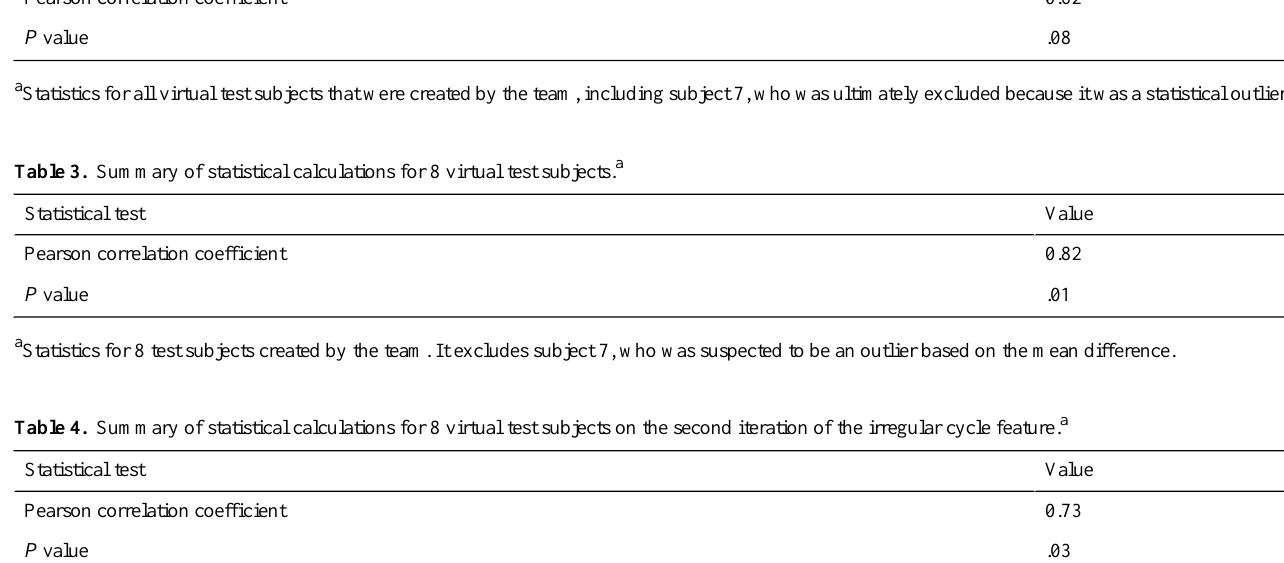
ValueStatistical test